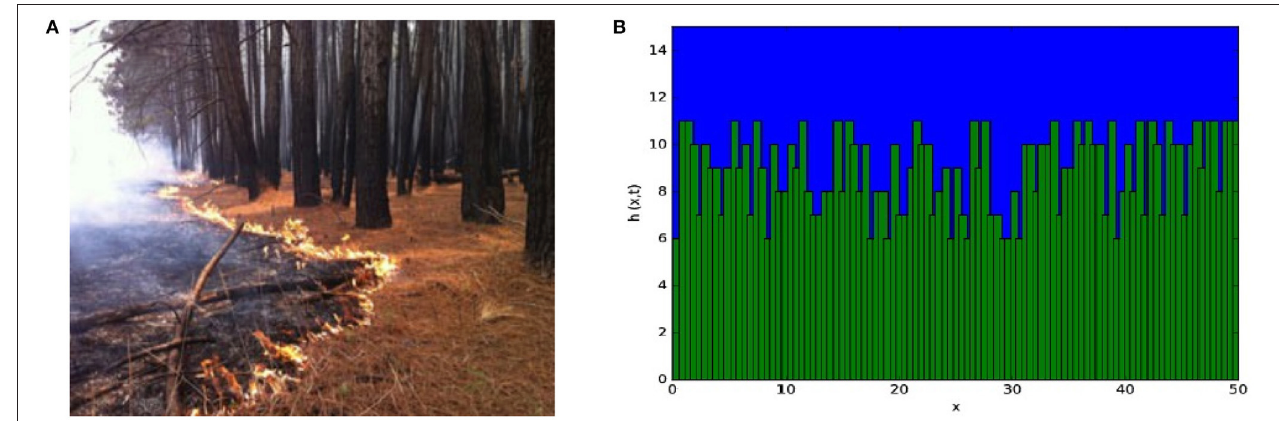
x , t ), defining the interface between two E